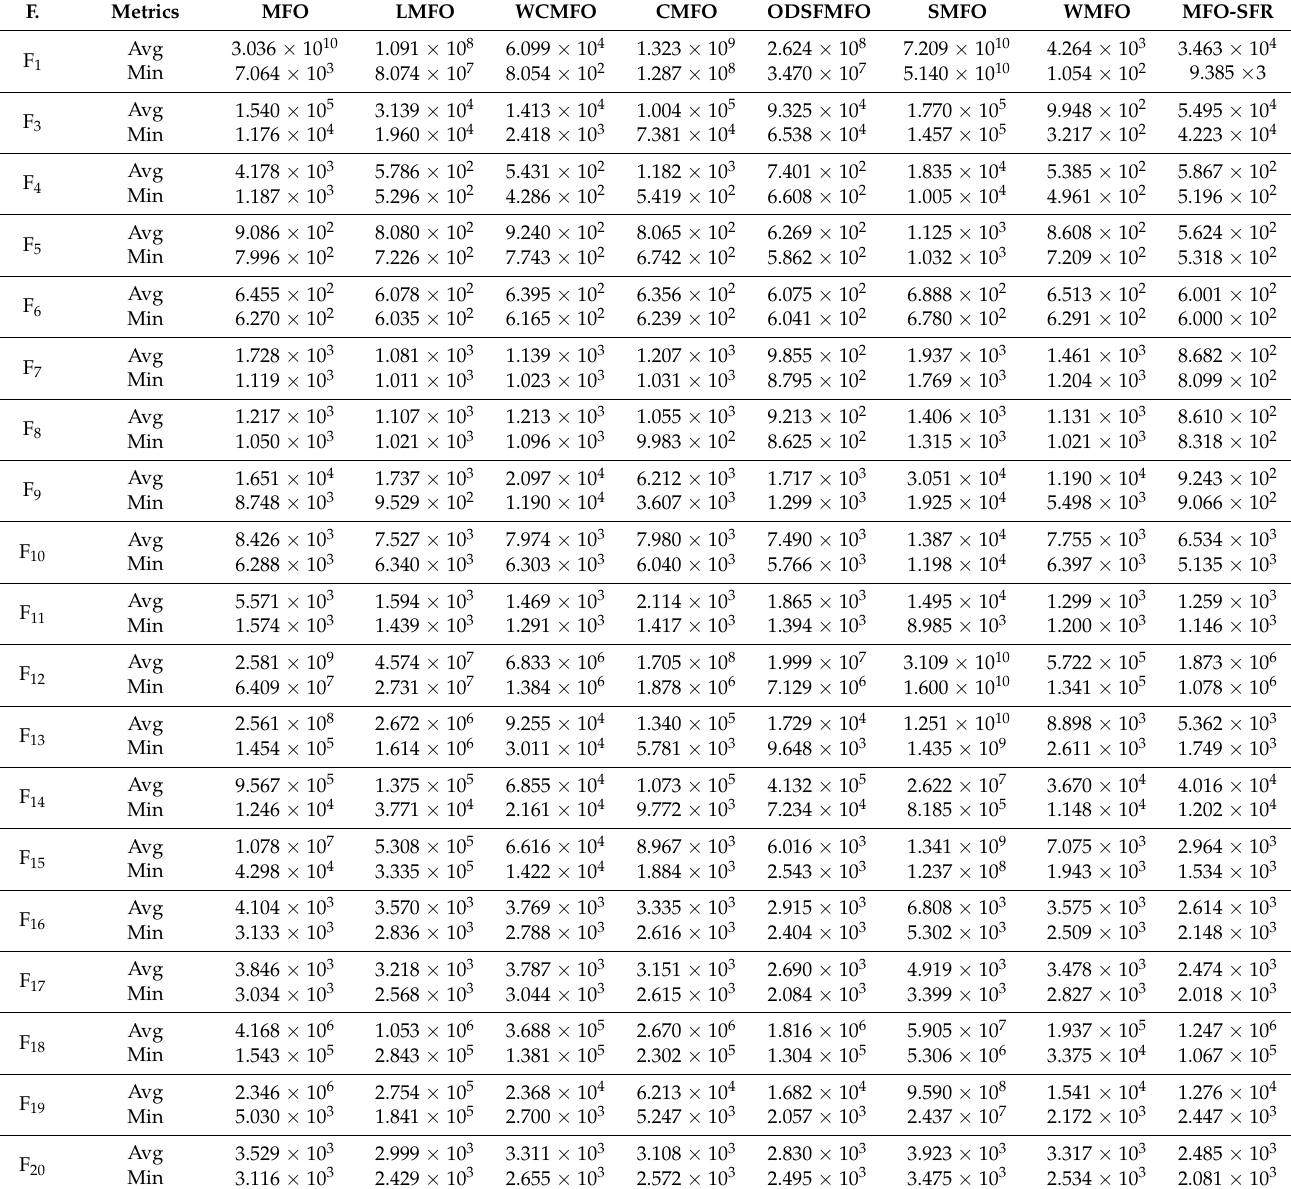
Table 4. Comparison of MFO-SFR with MFO variants for CEC 2018 test functions with D =